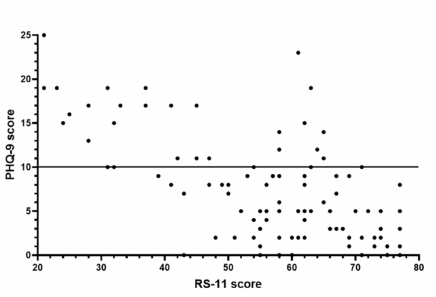
Figure 4. Correlation of the PHQ-9 score (depressive symptoms) with the resilience score. The correlation of the degree of depression (PHQ-9) with resilience (RS-11) was analysed for 102 iTTP patients ( r s = − 0.588, p < 0.0001) (every iTTP patient was analysed only once, the first evaluation of those that participated in both surveys was considered). The horizontal line indicates the cut-off for major depression (PHQ-9 score ≥